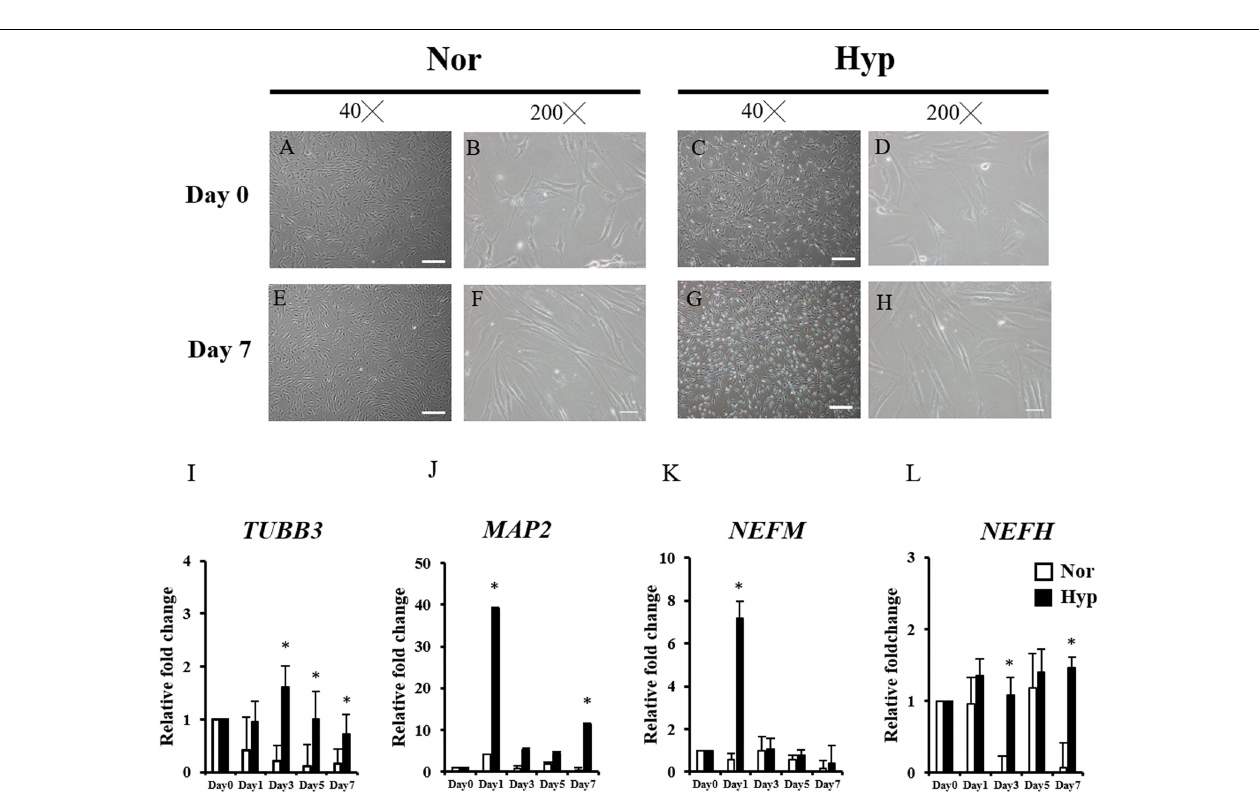
FIGURE 1 | Scheme of normoxic and hypoxic expansion and neuronal differentiation. Freeze-thaw or continuous-culturing human adipose-derived stem cells (ADSCs) at passages 3–5 were cultured under normoxic (normoxic ADSCs) or hypoxic condition (hypoxic ADSCs) for 2 weeks. After expansion, both the normoxic and hypoxic ADSCs were exposed to 2-Mercaptoethanol ( β -ME) to induce neuronal differentiation for 7 days. The neuron-related genes and proteins of the normoxic and hypoxic ADSC differentiated cells were monitored from days 0 to 7.